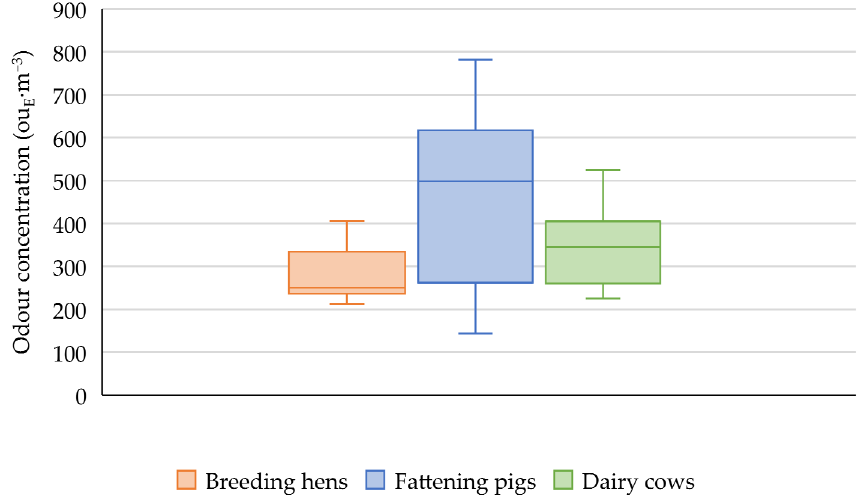
Figure 14. Odour emission Figure 13. Odour concentration.